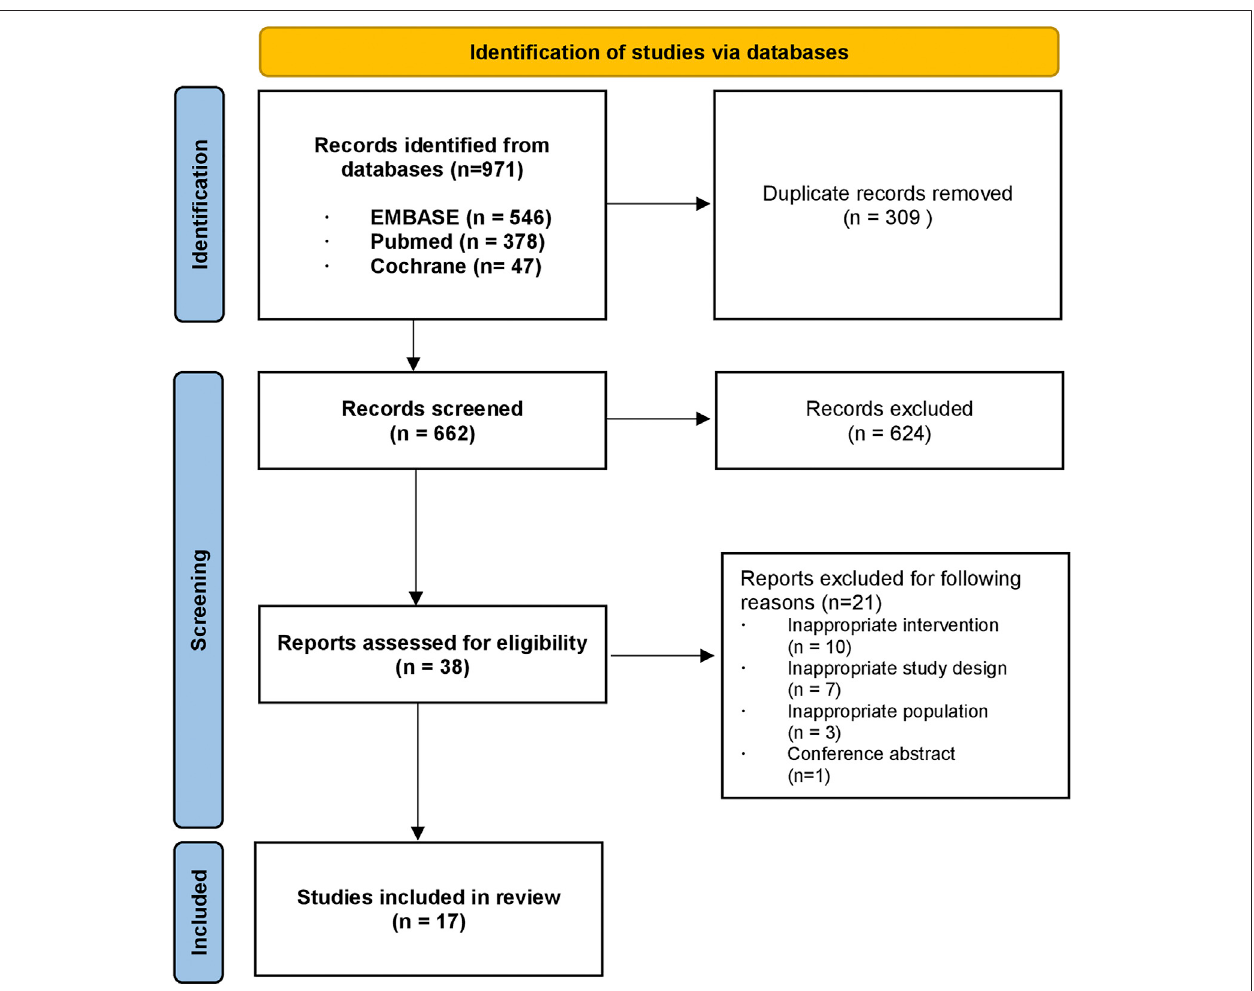
FIGURE 1 | Flow chart of the study selection